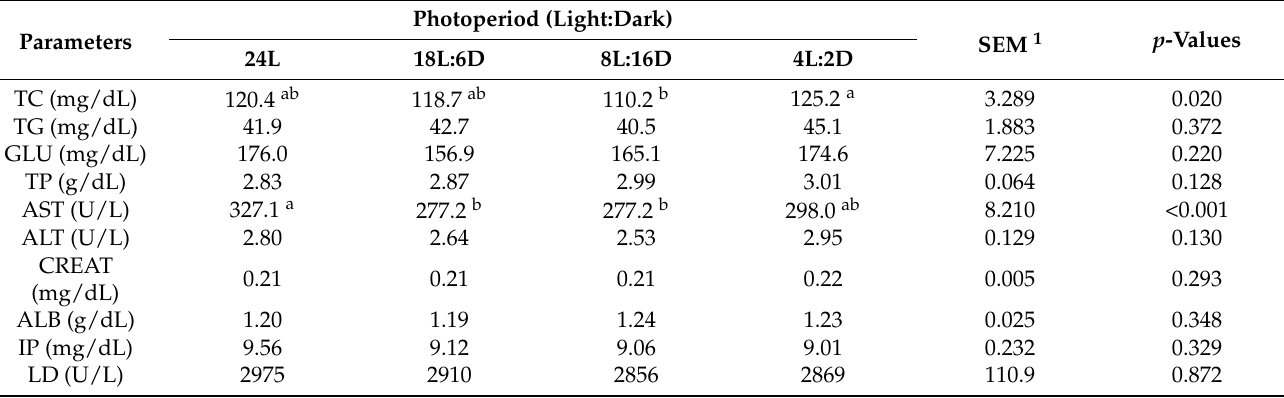
Table 4. Effect of photoperiod on serum biochemical composition of broilers.